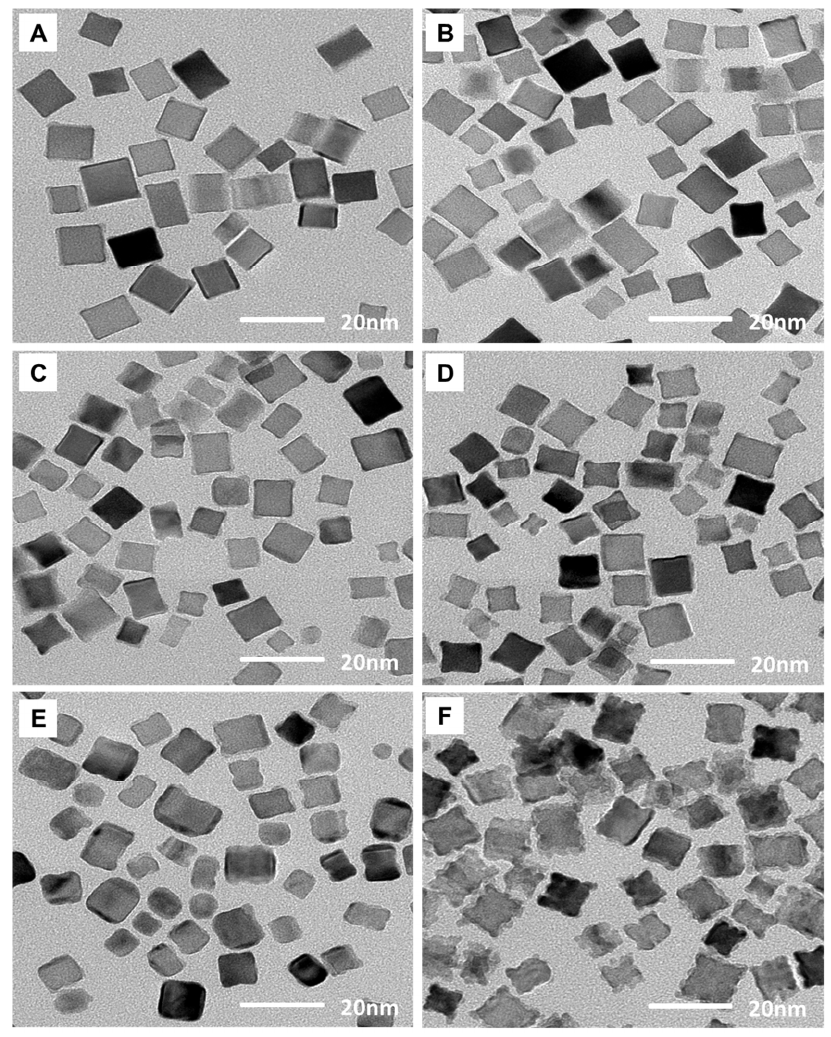
Figure 1. Transmission electron microscopy (TEM) images of AuPt@Pd nanoparticles with a range of Au and Pt mol% relative to Pd. The mol% of Au:Pt were ( A ) 2:1, ( B ) 1:2, ( C ) 5:2.5, ( D ) 2.5:5, ( E ) 25:5, and ( F )